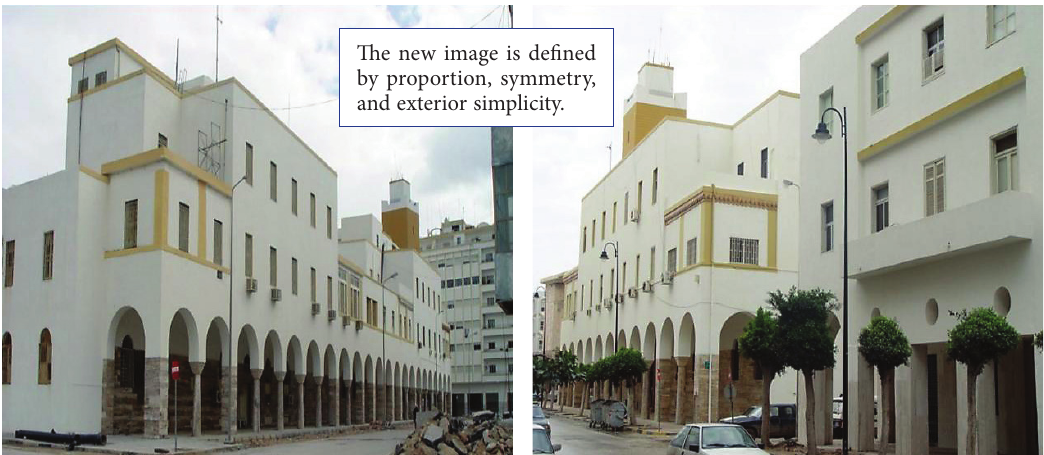
Figure 6. Th e connection between architecture and urban movement focuses on connecting pedestrian paths via building arcades (Harby, 2011)